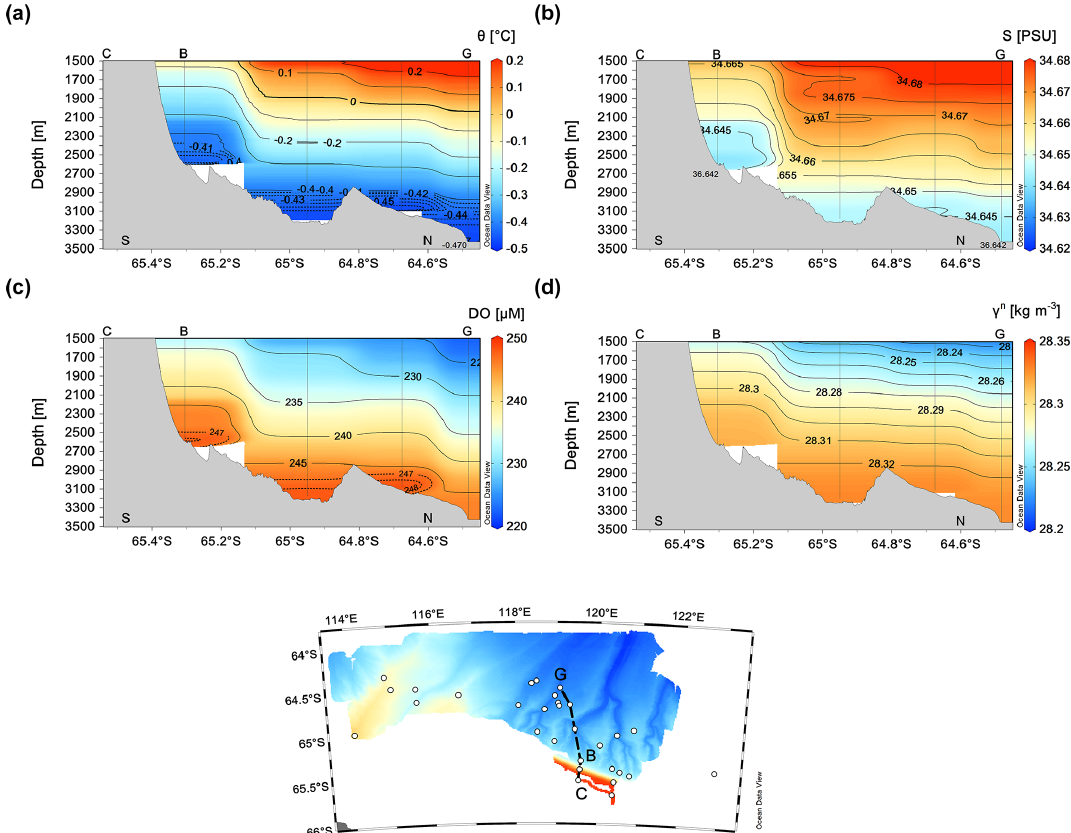
Figure 8. Same as Fig. 7 but with a zoom into the 1500m–bottom layer. The isoline steps are chosen to make evident small changes of the hydrographic properties near the bottom where waters are the coldest, the freshest, the densest, as well as rich in dissolved oxygen content. See the insert map for the location of the